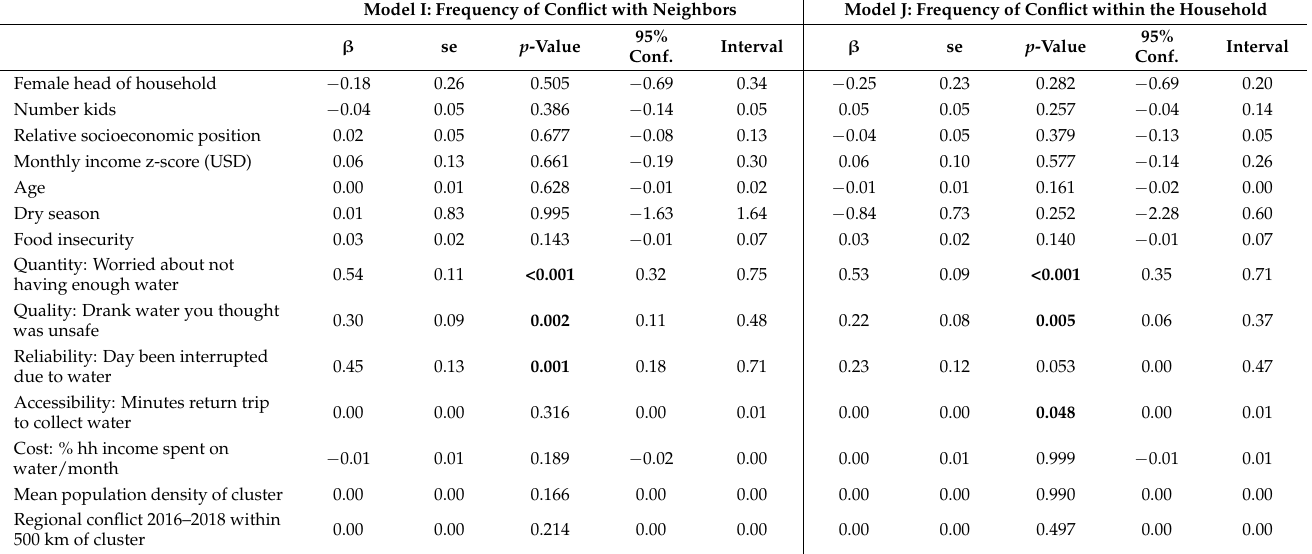
Table 8. Ordinal logistic regression modeling results for associations between demographic characteristics, water insecurity domains, regional conflict, population density, and conflict with neighbors (Model I) or within the household (Model J) in rural areas